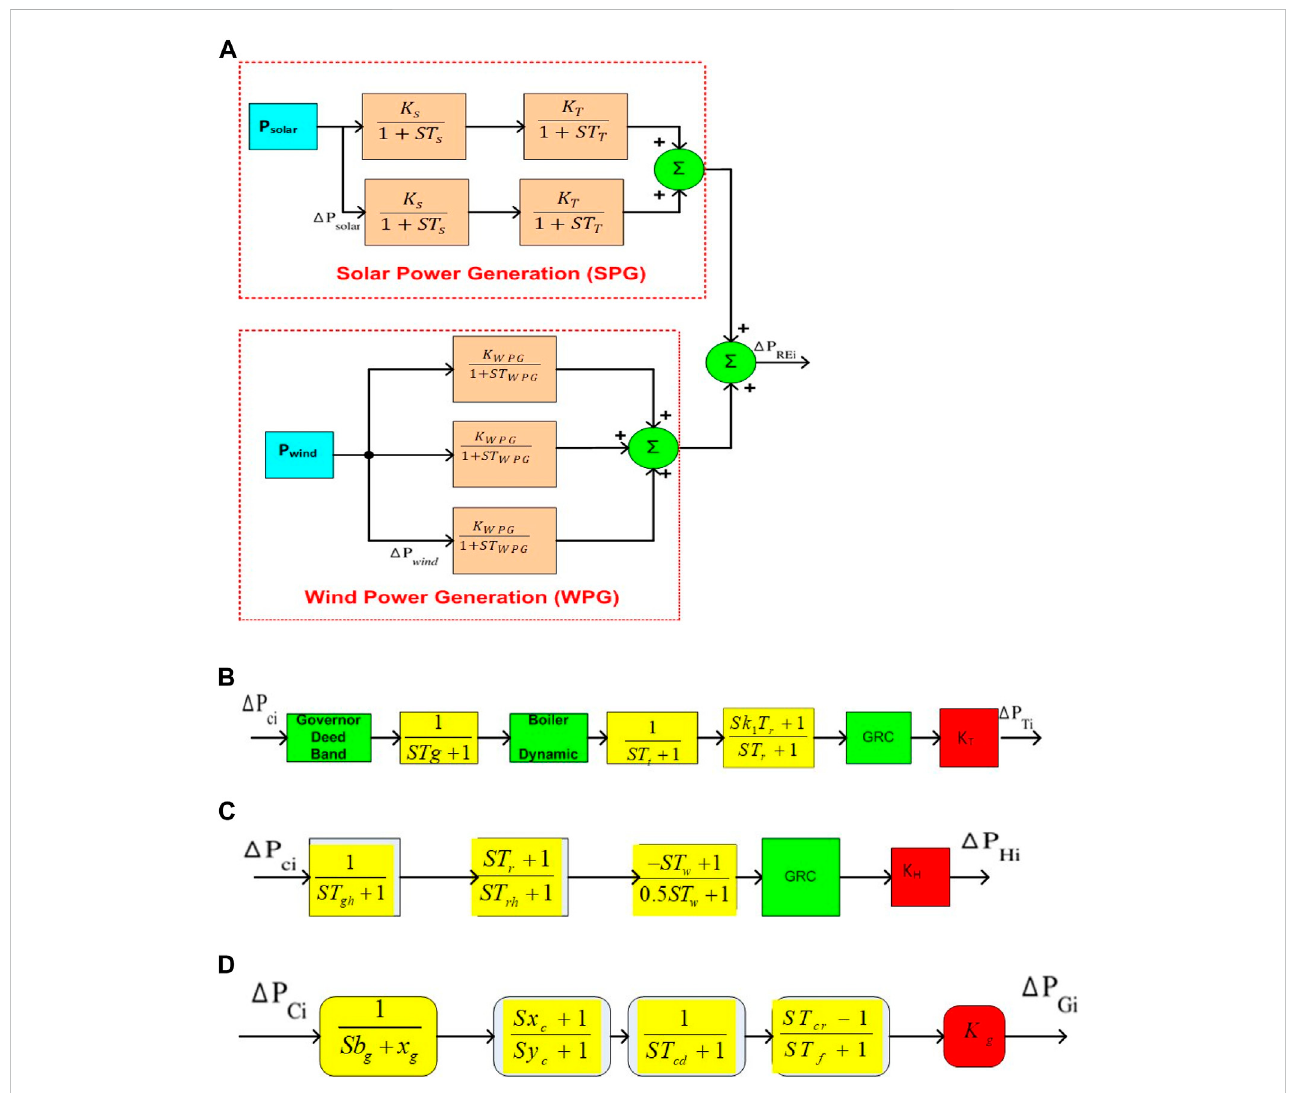
FIGURE 3 TF model of (A) Renewable Energy Sources (RES) (B) Thermal Reheat system (C) Hydro generation system (D) Gas generation system.